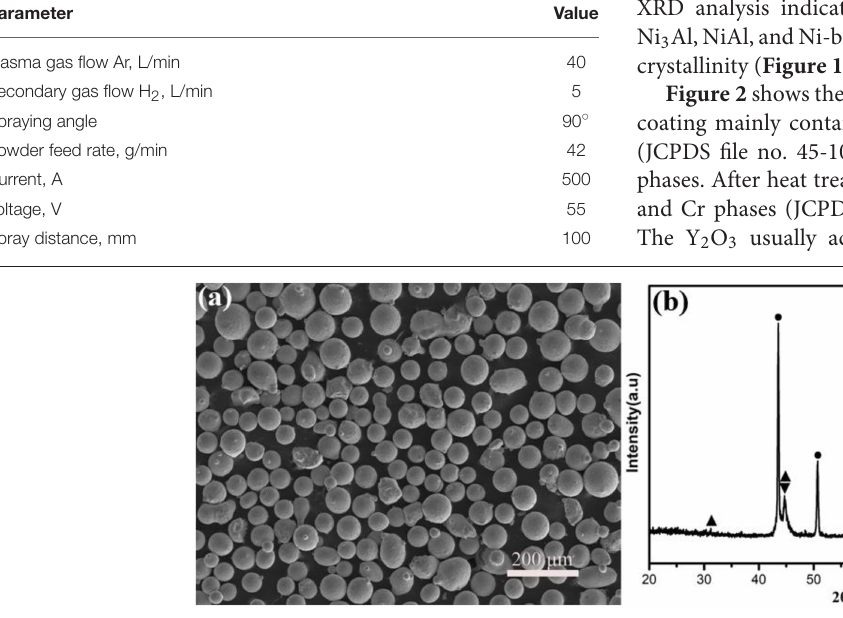
FIGURE 1 | SEM morphology (a) and XRD patterns (b) of NiCrAlY